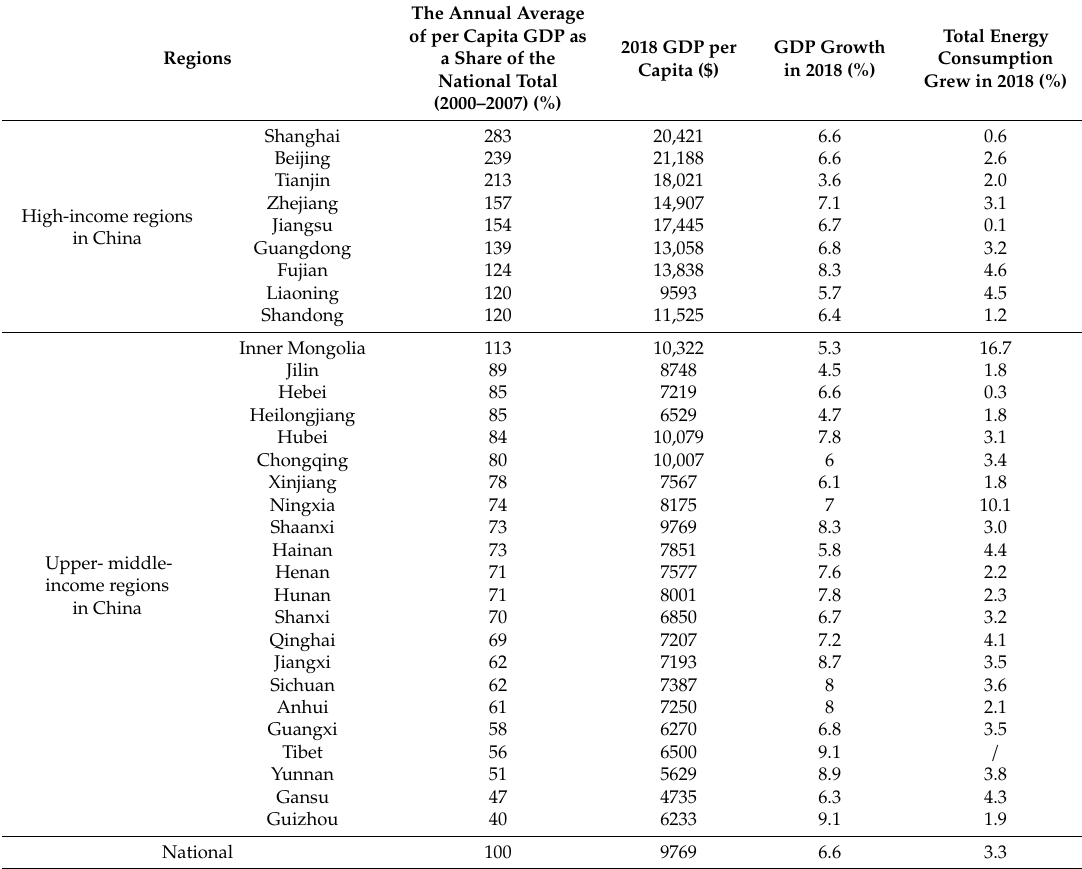
Table 1. Statistics on various indicators of GDP per capita in China’s high-income regions and China’s upper-middle-income